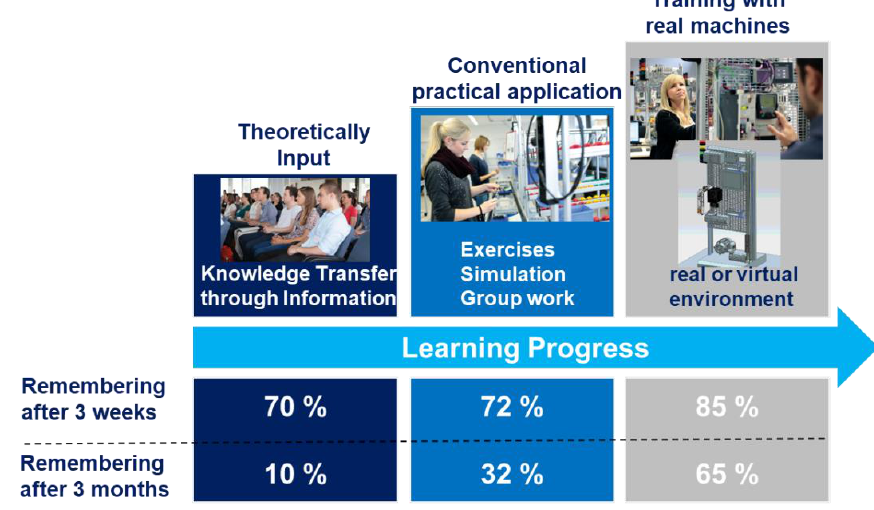
Figure 2. Various training opportunities in higher